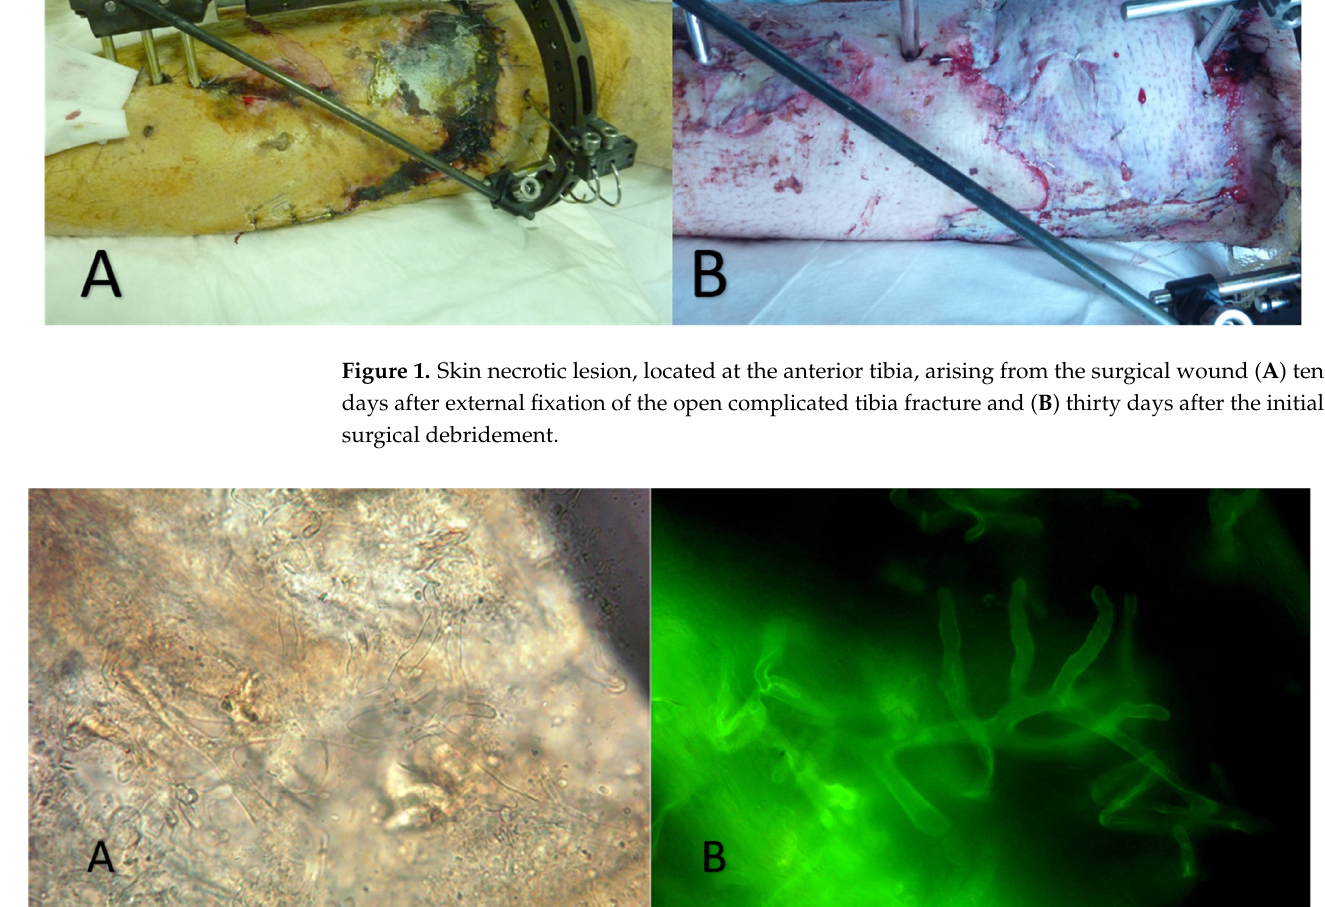
Figure 2. Direct microscopy: wet tissue mount examined with KOH and ( A ) Blankophor-P ( B ) broad, non- septate, ribbon- like hyphae with right-angle branching, characteristic of Mucorales.